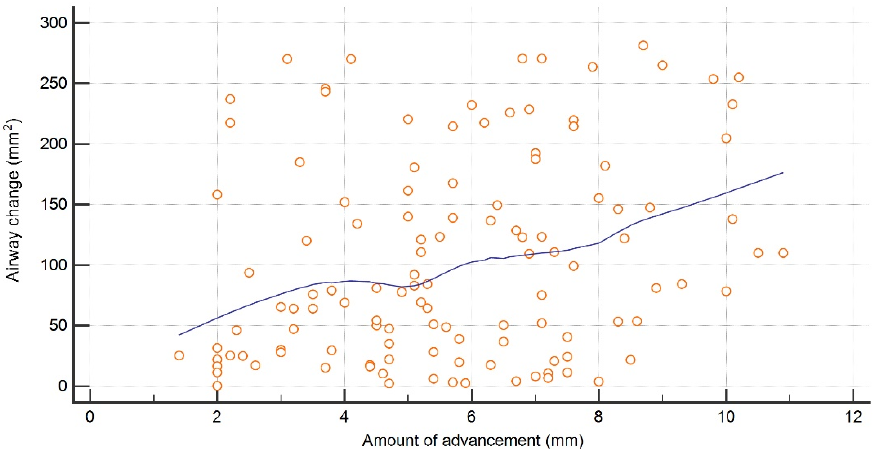
Figure 4. Correlation between amount of mandibular advancement and minimum cross-sectional area.